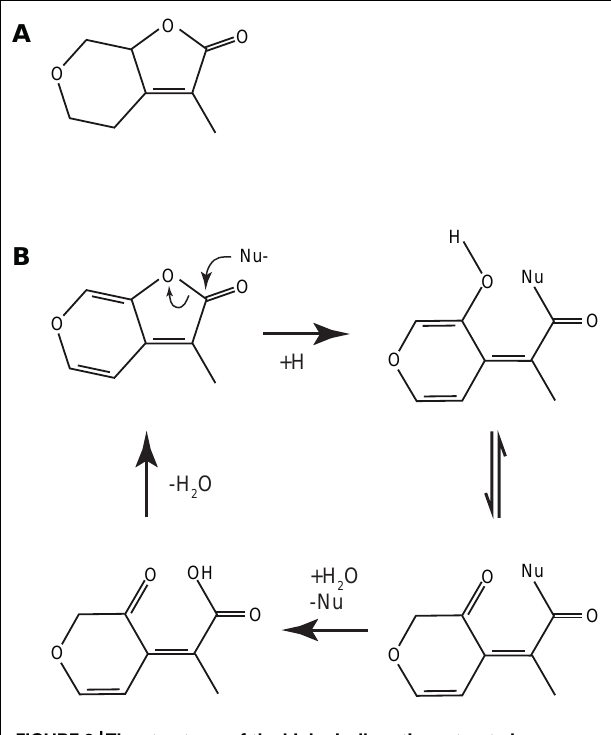
FIGURE 3 |The structures of the biologically active saturated karrikinolide (A). A putative scheme has been proposed (Scaffidi etal., 2012) for the nucleophilic attack of the α / β hydrolase showing the formation of the bound intermediate and the subsequent release to reconstitute the starting karrikin (B) .